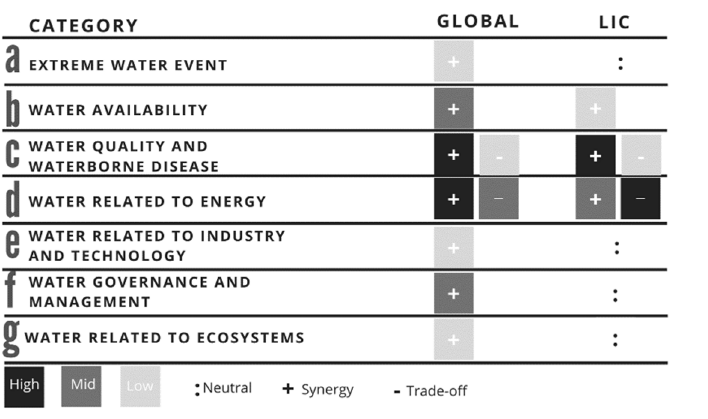
Figure 5. The expert judgment from percentage of interlinkage among indicators of water-related SDGs in global and low-income countries SDGs in global and low-income countries (LIC).